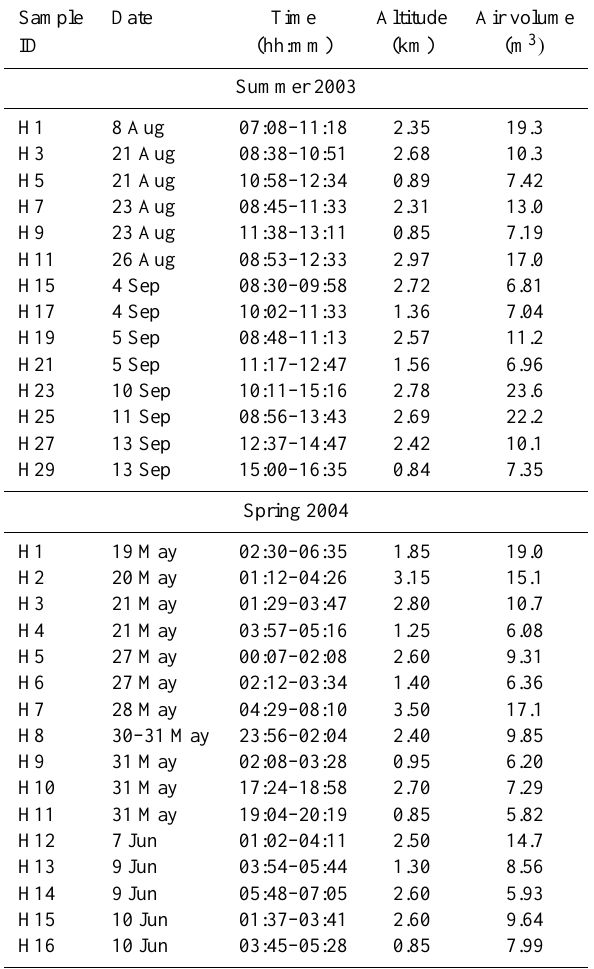
Table 1. Information on sample identification (ID) number, sample duration, flight altitude (above ground level, a.g.l.), and air volume of each sample collected during two aircraft campaigns. Complete flight tracks are shown in Fig.